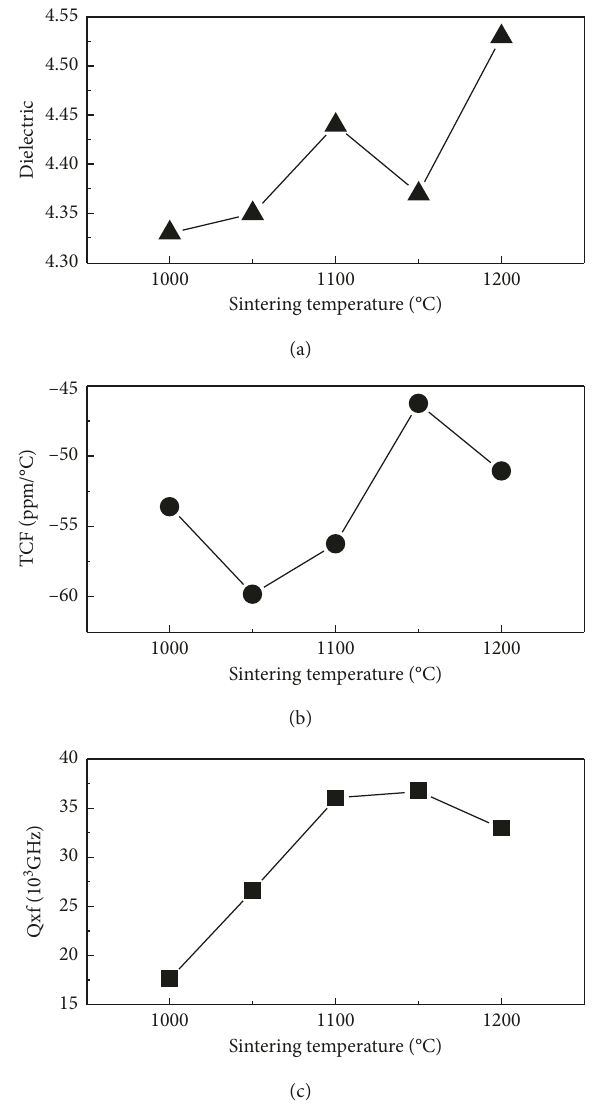
Figure 5: The dielectric constant perature coefficient of resonant frequency with 12% B 2 O 3 –LiF as a function of sintering